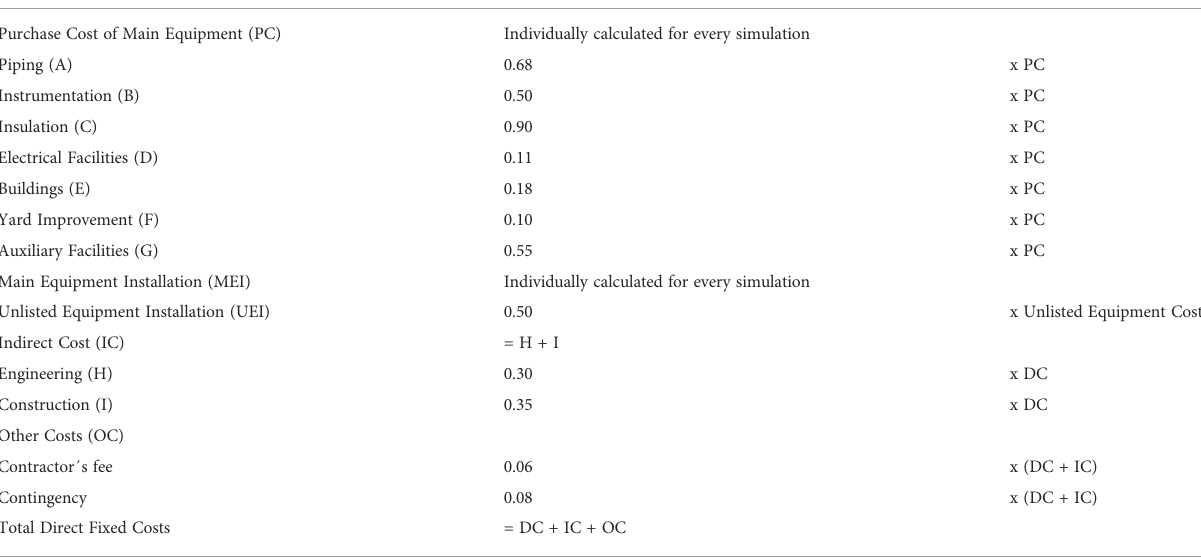
TABLE 2 Economic multipliers (Lang factors) for direct fi xed cost estimation based on equipment purchase